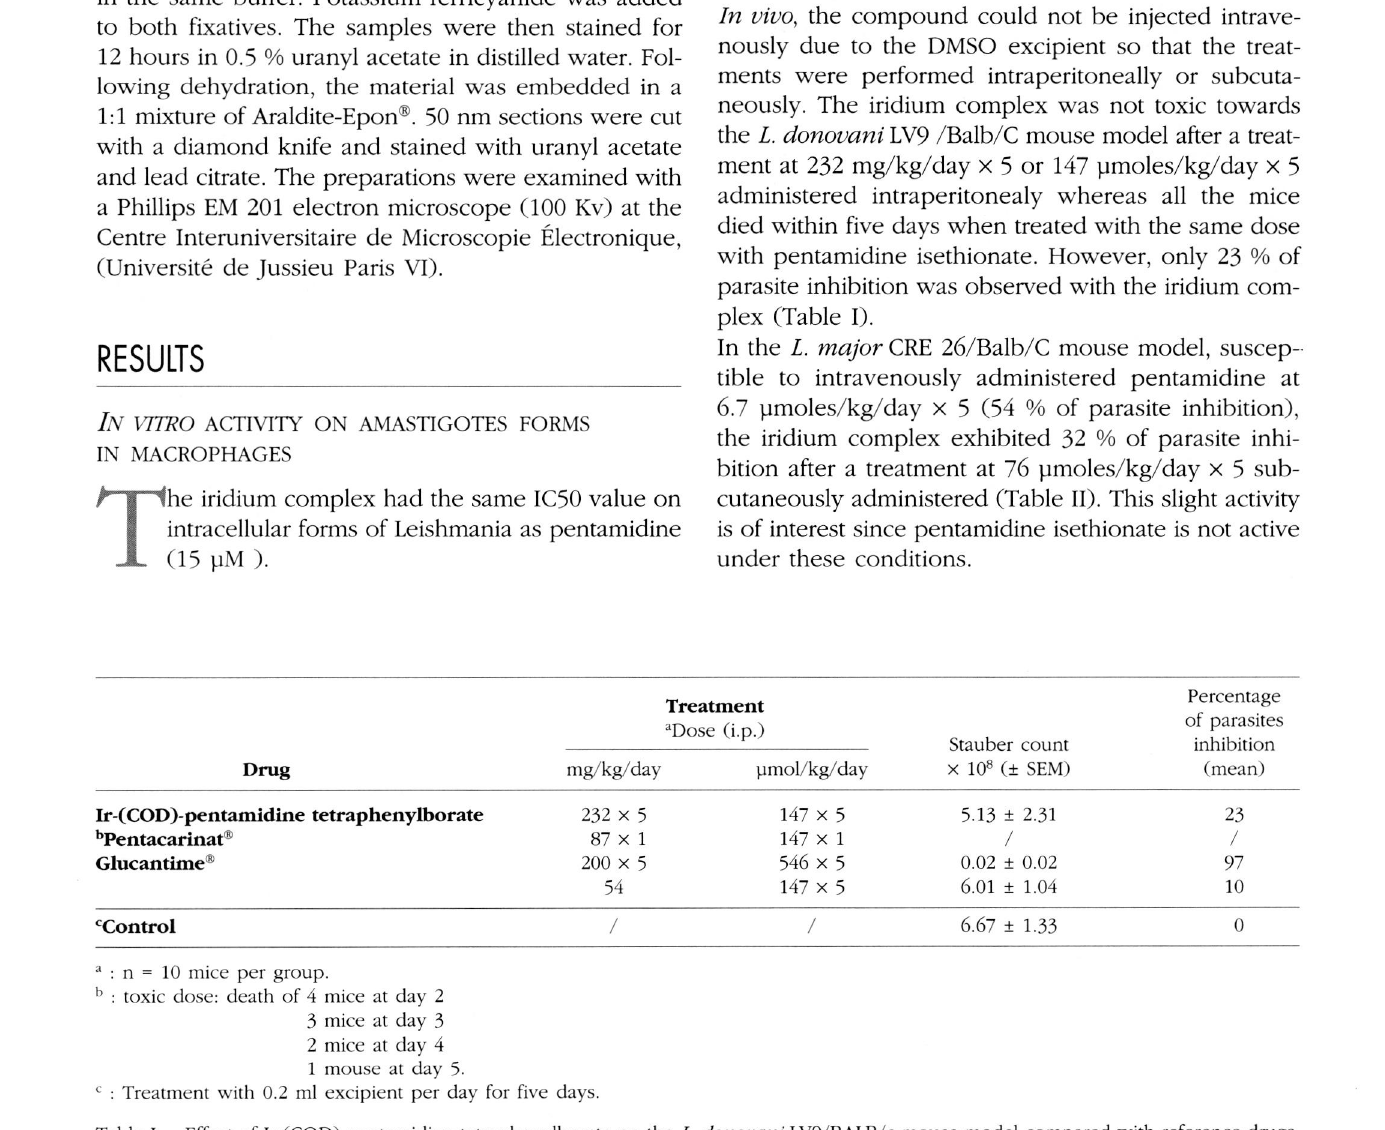
Table I. - Effect of Ir-(COD)-pentamidine tetraphenylborate on the L. donovani LV9/BALB/C mouse model compared with reference drugs. 232 mg/kg of Ir-(COD)-pentamidine tetraphenylborate corresponds to 50 mg equivalent pentamidine/kg. 200 mg/kg of Glucantime® cor­ responds to 56 mg SbVkg.